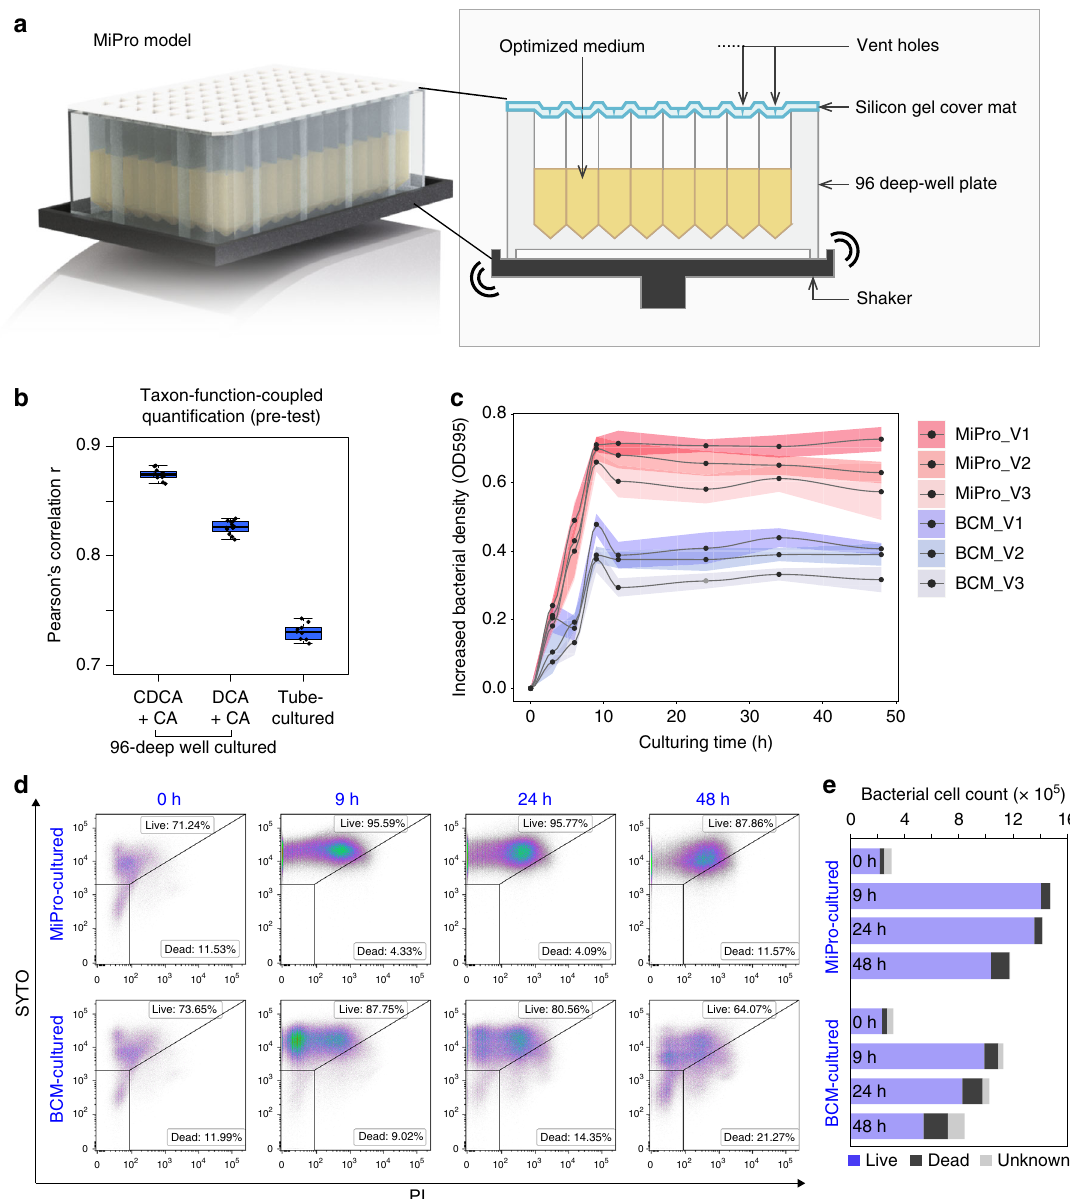
Fig. 1 Establishment and general performance of the MiPro model. a Main components of the MiPro model: microbiome samples are cultured in an optimized culture medium in a 96-deep well plate. The plate is covered with a silicone-gel cover perforated at the top of each well. The plate is shaken at 500 rpm on a digital shaker. b Pearson ’ s correlation coef fi cient r of taxon-speci fi c functional pro fi les between the inocula (0 h baseline sample) and 96- deep well-cultured microbiome with the presence of primary bile salts (CDCA + CA) or commercialized bile salts mixture (DCA + CA), as well as tube- cultured microbiome with the presence of primary bile salts. Different letters indicate signi fi cant differences at the p = 0.05 level, Tukey-b test; box spans interquartile range (25th to 75th percentile), and line within box denotes median. Whiskers represent min to max values. n = 3 biologically independent microbiomes. c Increase in bacterial biomass over time in each individual microbiome (determination using absorbance at 595 nm). Colored ribbons indicate the range of standard deviations around the means ( n = 4 technical replicates for each treatment). d Temporal microbiome viability changes as shown with fl ow cytometry. The gating strategy is shown in Supplementary Fig. 3. ( e ) Bacterial cell count in each fl ow cytometry recording. Data were recorded for 2 min on the low fl ow rate setting. Underlying data are provided in the Source Data fi determine bacterial biomass density, and used fl ow cytometry to microbiome, which is vital for an effective in vitro microbiome determine bacterial cell counts. At 24 h the OD 595 was 0.8 ± 0.1 response study. Temporal changes in parameters including fold higher (i.e., 80% higher) in the optimized medium as com- microbial biomass, cell count, viability and diversity were com- pared to that cultured in BCM (Fig. 1c). Furthermore, using fl ow pared with the 0 h baseline sample. The commonly used basal cytometry in combination with viability staining, we found that culture medium (BCM) was included for comparison. Since dif- our MiPro medium achieved high ratio of viable bacterial cells ferent microbial members can differ by several orders of magni- throughout the culture period (95.8% at 24 h compared with tude in biomass 27 , it is necessary to examine both biomass and bacterial counts. We used optical density at 595 nm (OD 595 ) to 71.2% at 0 h, Fig. 1d). Comparison of the fl ow cytometry readouts